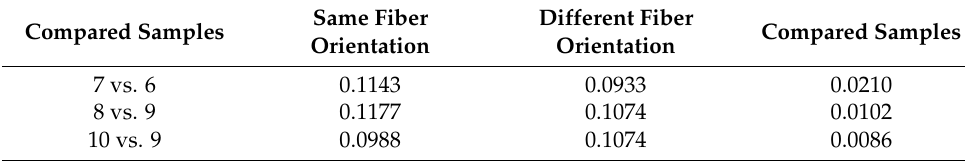
Figure 9. Difference in weight loss in Samples 6 – 10, represented graphically. Table 9. Weight differences in samples 6 – 11 (g). Compared Samples